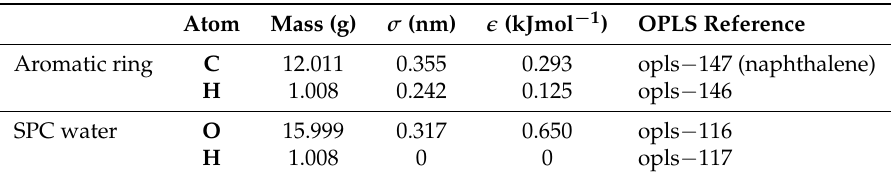
Table 1. Forcefield parameters for the non-bonded interactions. The symbols, (cid:101) and σ , denote the energy and diameter parameters used in Lennard–Jones